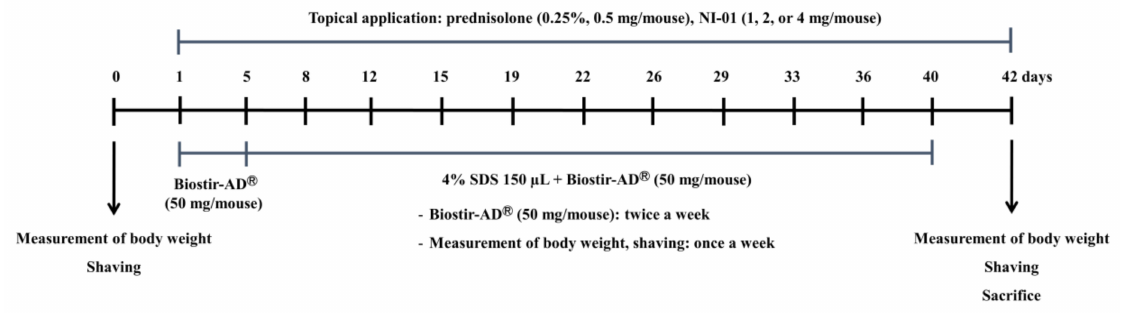
Figure 2. Summary of the experimental